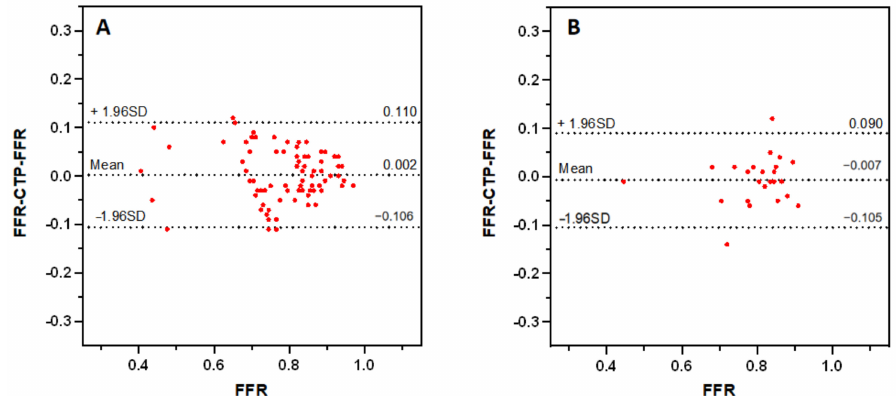
Figure 5. Bland–Altman analysis of FFR and CTP-FFR on a per-vessel basis in low calcification (( A ), CAC < 400) and severe calcification (( B ), CAC ≥ 400), respectively. The distribution of red points represents the consistency of CTP-FFR with FFR. CAC = coronary artery calcium. Other abbreviations as in Figure